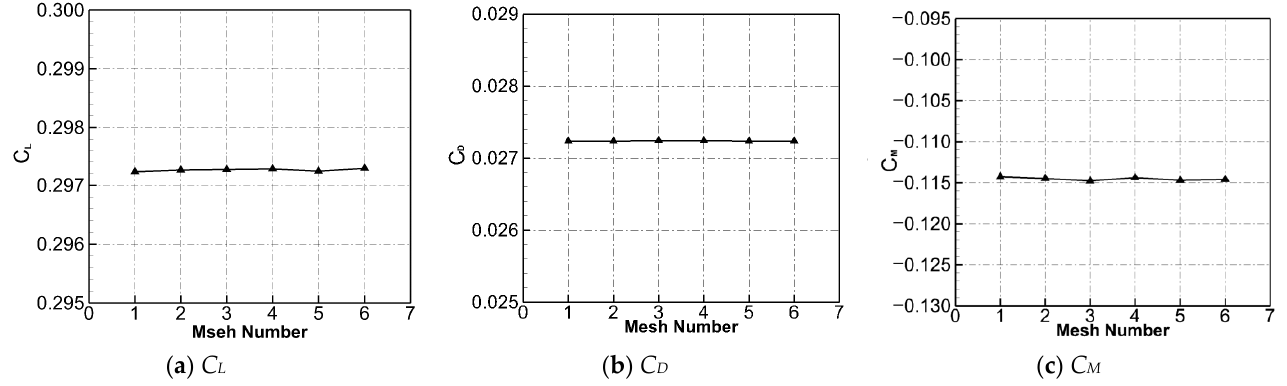
( c ) Y + of Mesh 5 Figure 5. Y + of grid independence verification. 2.3. Comparison of CFD Results with Wind Tunnel Data The experiment was carried out by the FL-2 wind tunnel in AVIC (Aerodynaiviics Research Institute of China). The FL-2 wind tunnel is a high-speed wind tunnel for a lam- inar experiment. The experiment adopted a 1:9.8 scale model, Ma = 0.7, Re = 8 × 10 6 , side- slip angle = 0°, FSTI = 0.6%. The FSTI specified at an inlet can decay quit rapidly depending on the inlet viscosity ratio (and hence turbulence eddy frequency). As a result, the local FSTI downstream of the inlet can be much smaller than the inlet value. Typically, the larger the inlet viscosity ratio, the smaller the turbulent decay rate. However, if too large a viscosity ratio is specified (i.e., >100), the skin friction can deviate significantly from the laminar value. There is experimental evidence that suggests that this effect occurs physi- cally; however, at this point, it is not clear how accurately the transition model reproduces this behavior. For this reason, if possible, it is desirable to have a relatively low (i.e., =10) inlet viscosity ratio and to estimate the inlet value of FSTI such that at the leading edge of the wall of the airfoil the FSTI has decayed to the desired value. The grid calculated in Section 2.2 was used to complete the comparison. Figure 6 shows the transition compari- son between the experimental results of the wind tunnel and the calculated results when α = 0°and α = 1°. The left side of (a) and (b) are the calculated results of the skin friction coefficient of the central experimental wing, while the right side is the experimental ther- mographic image. It can be seen from the experimental thermographic image that the transition zone of the central experimental wing presents a zigzag feature, which is differ- ent from the smooth transition zone presented by the calculation result. It is because the surface of the experimental model has a certain degree of roughness, which leads to the advance of the local transition. Thus, the experimental transition position is taken as the maximum chordwise distance that can be achieved in the laminar flow zone. It can be seen